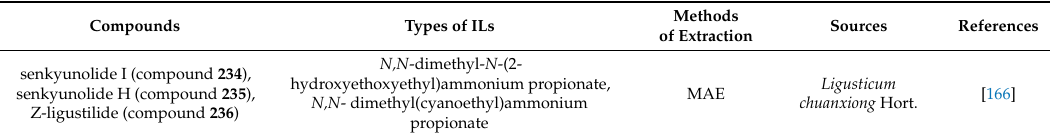
Table 9. The other compounds extracted from natural sources using ILs or IL solutions by different extraction